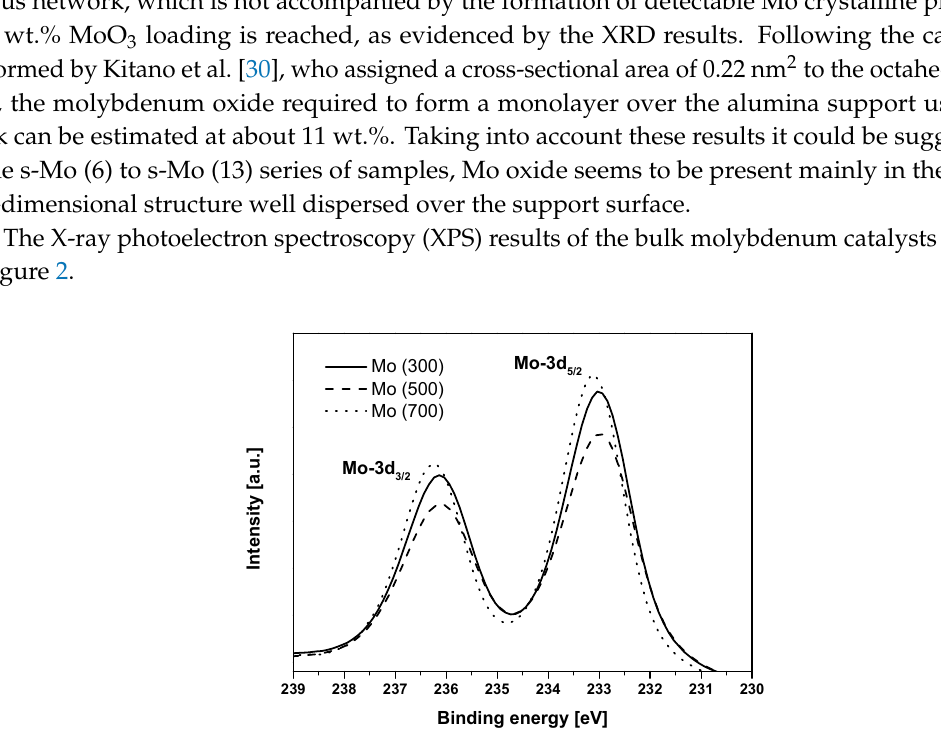
Table 1. Physicochemical characterization data of the supported MoO 3 catalysts.